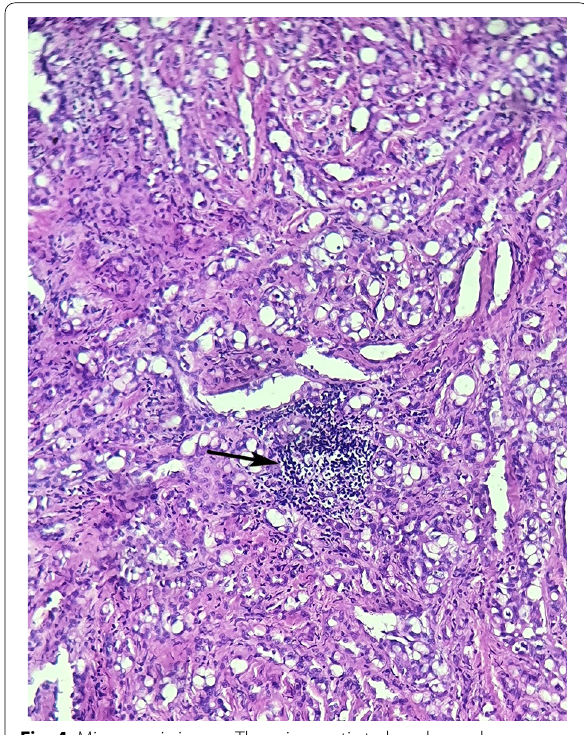
Fig. 4 Microscopic image: The microcystic trabeculae and spaces are lined by flattened cells with prominent vacuolization disposed within fibrous stroma with scattered inflammatory lymphocytes sometimes arranged in follicles (black arrow) (hematoxylin and eosin stain